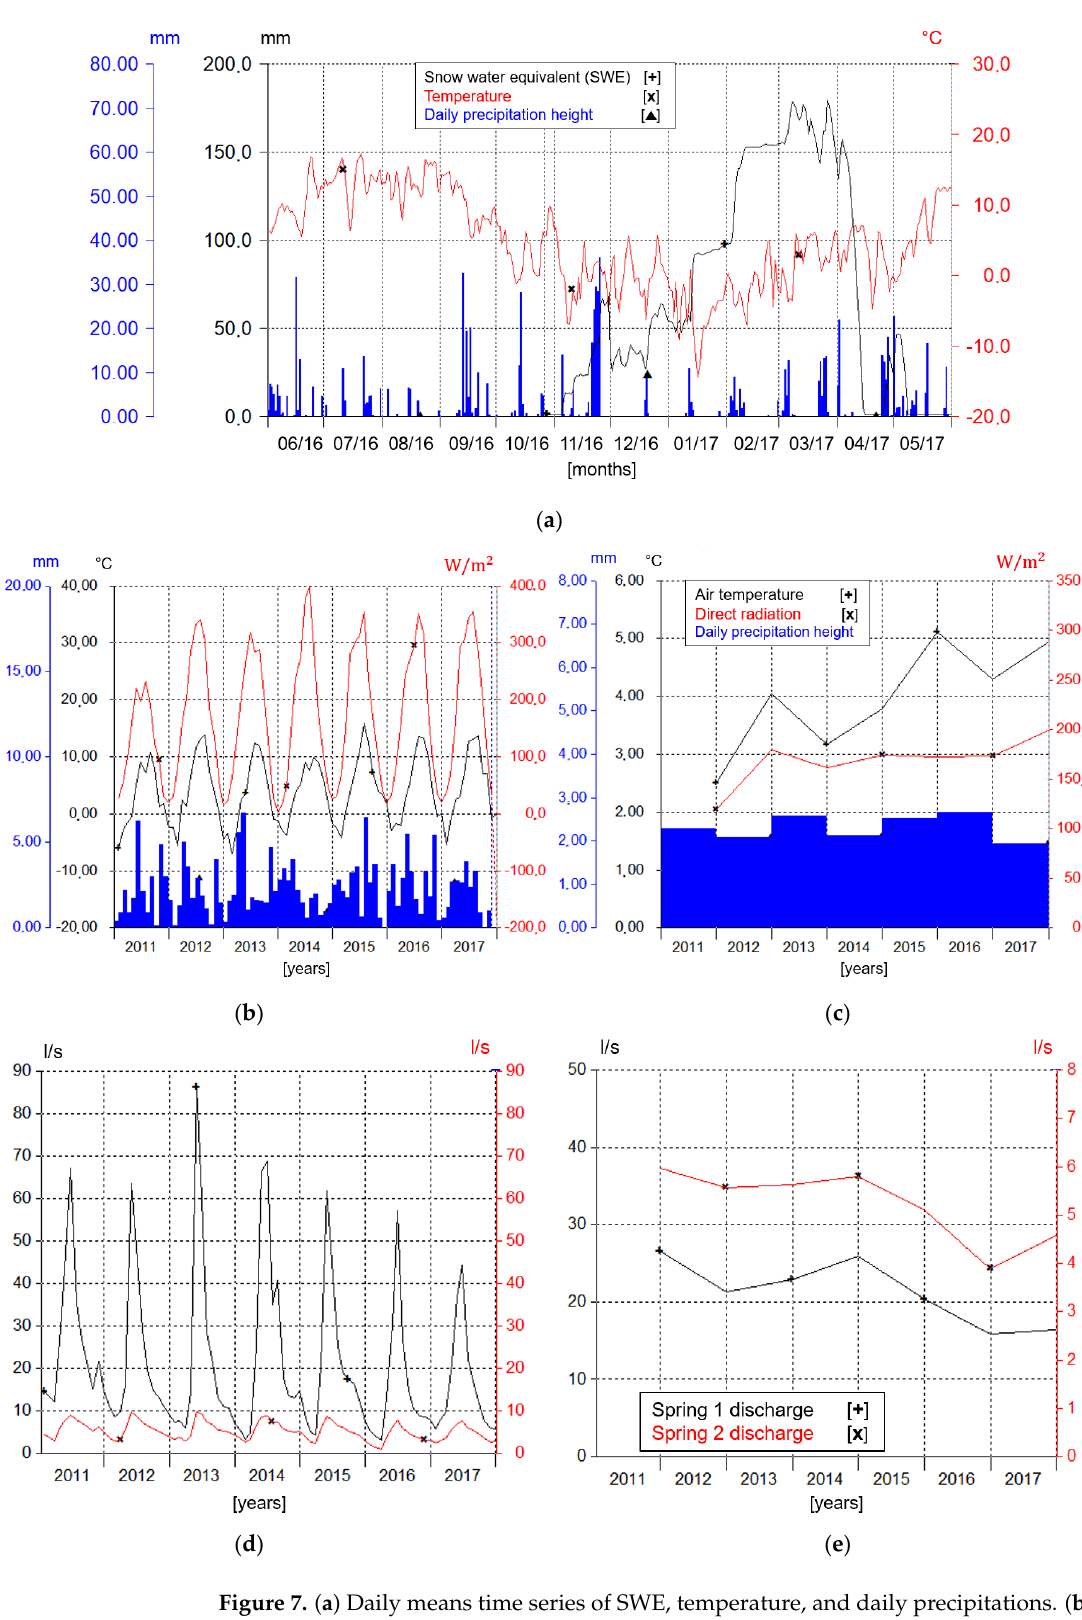
Figure 7. ( a ) Daily means time series of SWE, temperature, and daily precipitations. ( b , c ) Monthly means and yearly mean values of air temperature, direct radiation, and daily precipitations height. ( d , e ) Monthly means and yearly means values of discharge were detected in both springs. (Hydras 3 software